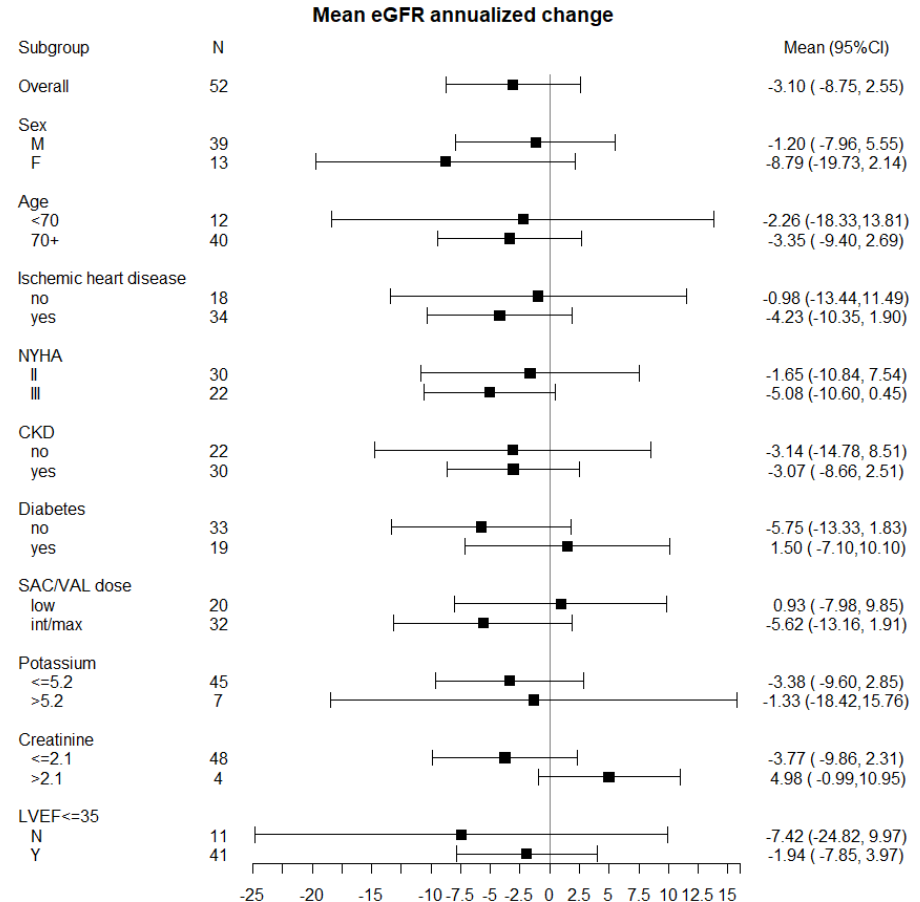
Figure 1. Mean eGFR annualized change, overall and by subgroups. M: male gender; F: female gender; NYHA: New York Heart Association; CKD: Chronic Kidney Disease; SAC/VAL: Sacubi- tril/Valsartan; int/max: intermediate/maximum dose; LVEF: left ventricular ejection fraction; N: No; Y: Yes. Table 2. Evolution of renal and cardiac parameters, from baseline to last follow-up.